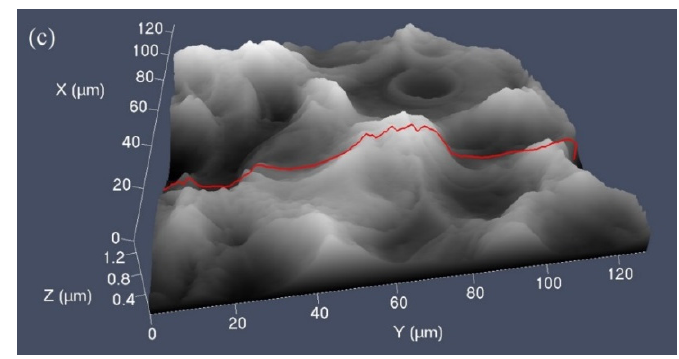
Figure 4. Laser topography images of spray-on P3HT:PCBM films: ( a ) one spray pass, ( b ) 15 spray passes, and ( c ) 30 spray passes. Carrier air pressure is 0.1 MPa, precursor